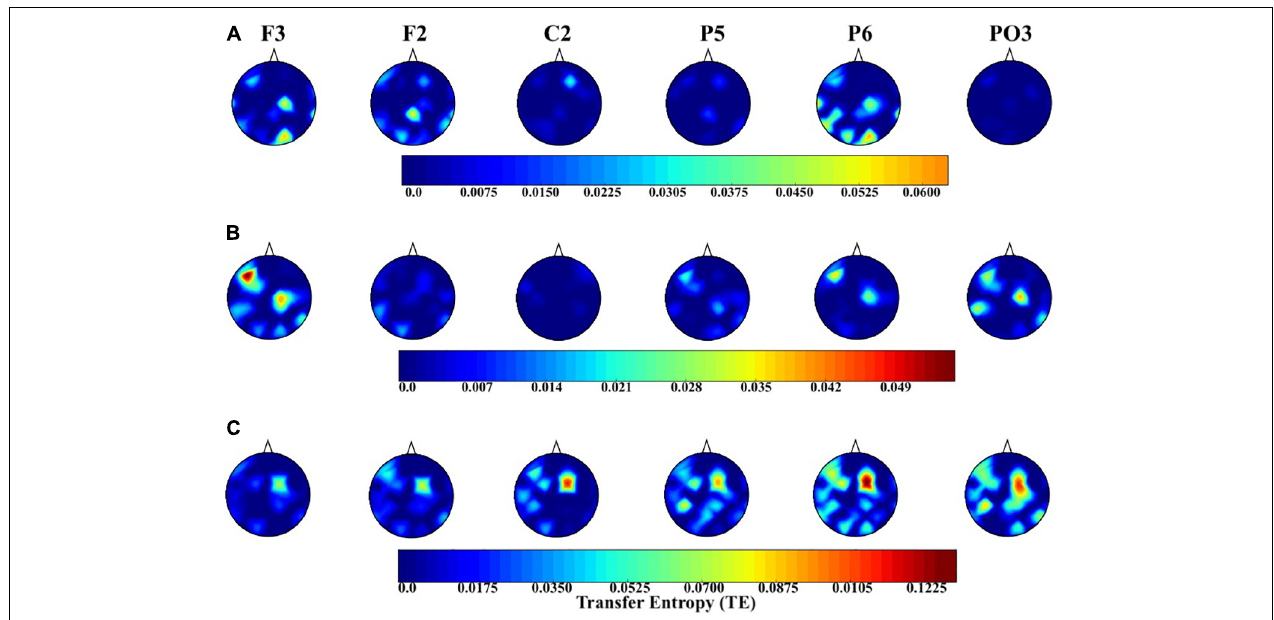
FIGURE 6 | Distribution of information flow from the common channels (i.e., F2, F3, C2, P5, P6, and PO3) to the remainder of channels in the AF ( A level in the image), AM ( B level in the image), and EM ( C level in the image) settings. In this figure, the source (i.e., region from which the information flowed to the other regions) is highlighted at the top of each subplot.